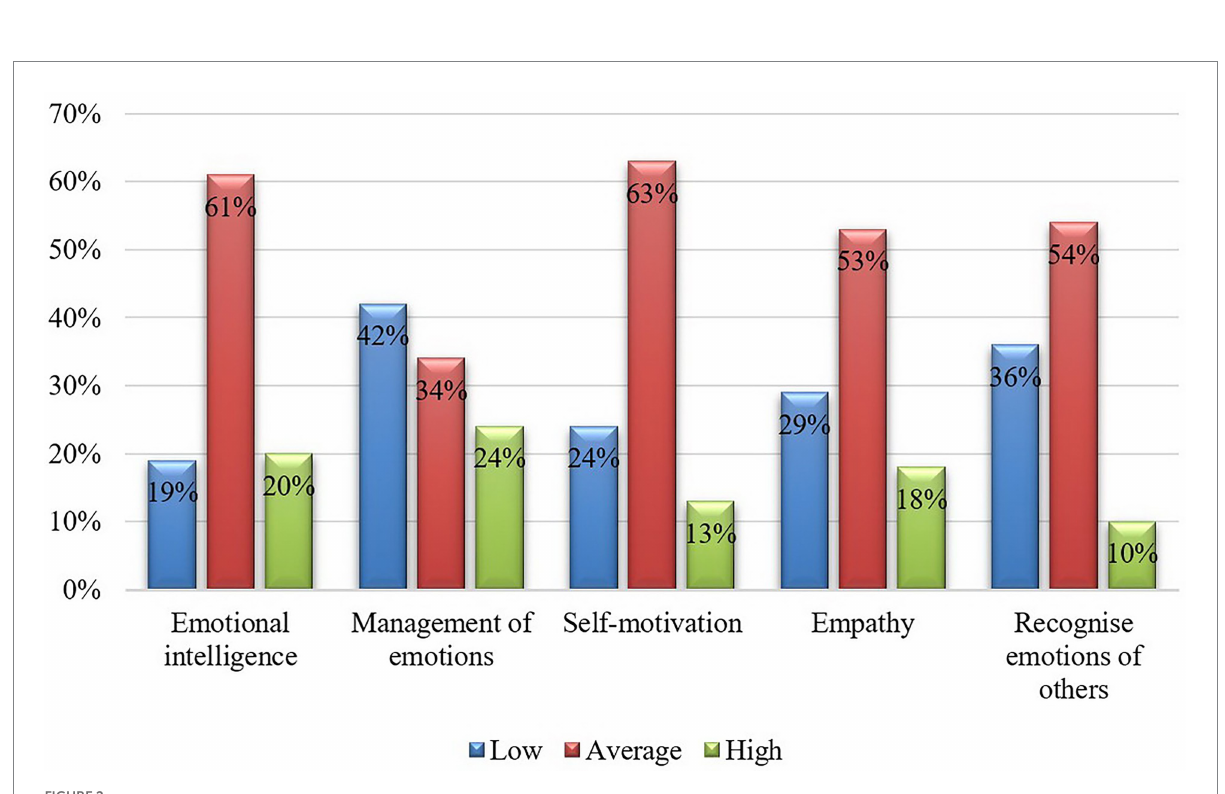
FIGURE 2 The results of tests on emotional